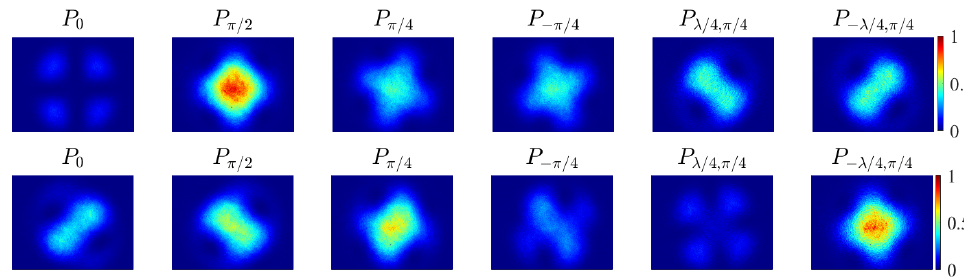
Figure 4. Measured power maps normalized to the maximum intensity value of the input beam. Top: input beam for all samples; Bottom: output beam in the case of a QWP with its fast axis at π /3 with respect to the horizontal direction.